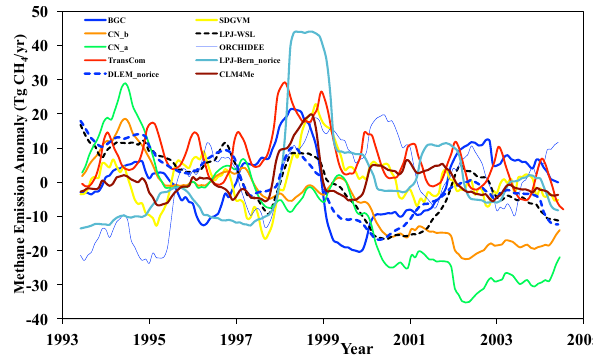
Figure 18. Similar to Fig. 16, but showing the models that par- ticipate in WETCHIMP (Melton et al., 2013; Wania et al., 2013). Each model uses a different wetland extent to estimate methane emissions (see Table 1 in Melton et al. (2013) for wetland deter- mination scheme in each model). LPJ–WSL prescribes the wetland area from a monthly inundation data set (Prigent et al., 2007, Papa et al., 2010). DLEM_norice prescribes the maximum wetland area from the inundation data set with simulated intra-annual dynam- ics. Sheffield Dynamic Global Vegetation Model (SDVGM) uses the internal hydrological model to determine wetland locations. All other models parameterize wetland areas based on an inundation data set or a land cover data set, which produce different interan- nual and intra-annual variability in wetland areas. Please also refer to Melton et al. (2013) for a detailed description of each model (SD- VGM, LPJ–WSL, ORCHIDEE, LPJ–Bern_norice, DLEM_norice, CLM4Me).